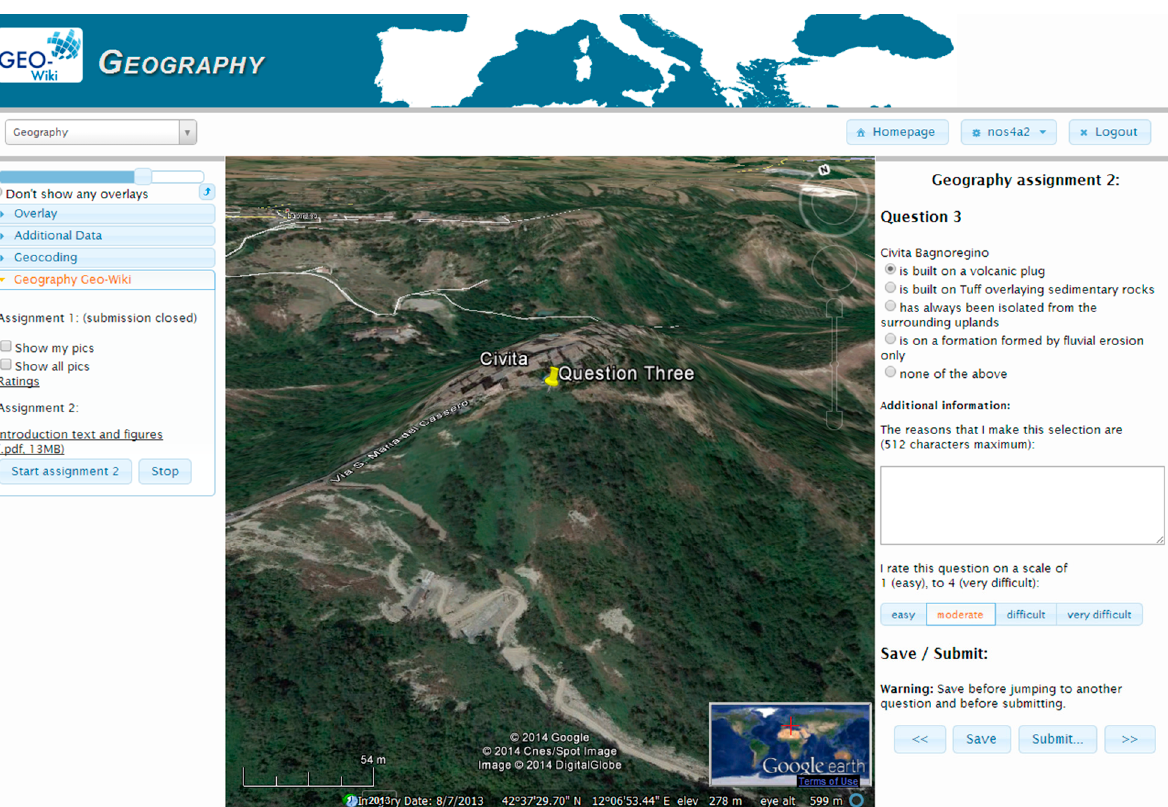
Figure 4. Example of a more interactive type of assignment utilizing Google